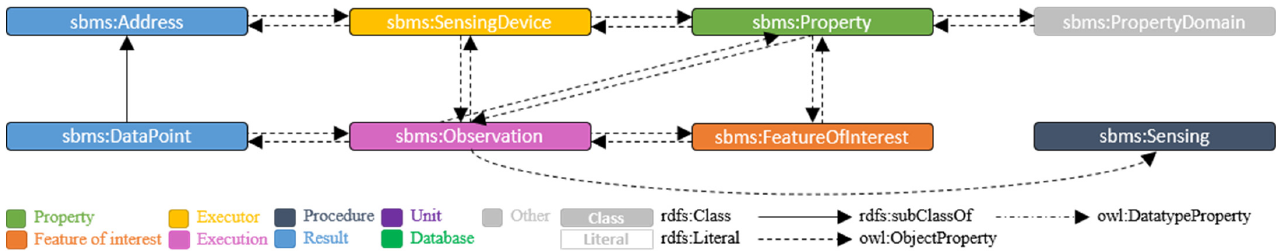
Figure 19. Using datapoints to represent dynamic property values in SBMS.